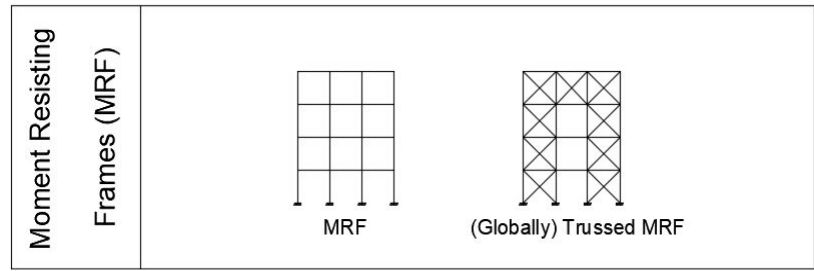
Figure 14. Nomenclature for the main types of moment resisting frames.